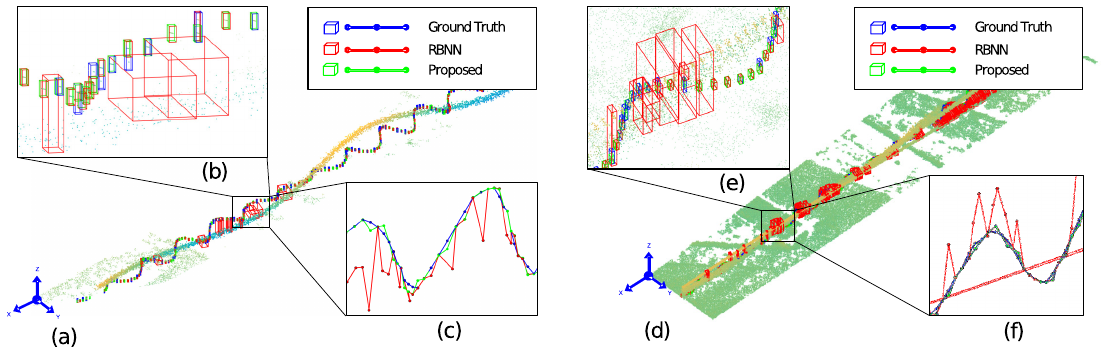
Figure 11. Experimental results of small drone detection. ( a ) detection result using dataset #1, ( b ) bounding box results for each frames, ( c ) Euclidean distances between sequential targets, ( d ) detection result using dataset #3, ( e , f ) show bounding box and